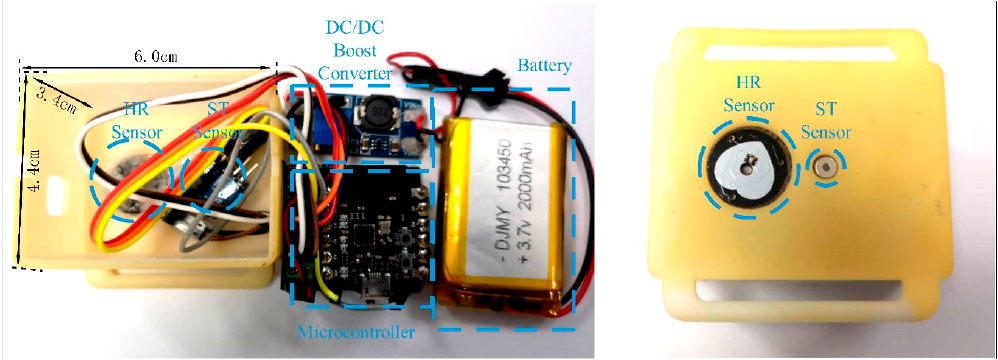
Figure 6. Device of the designed slave unit. Electronics 2019 , 8 , 441